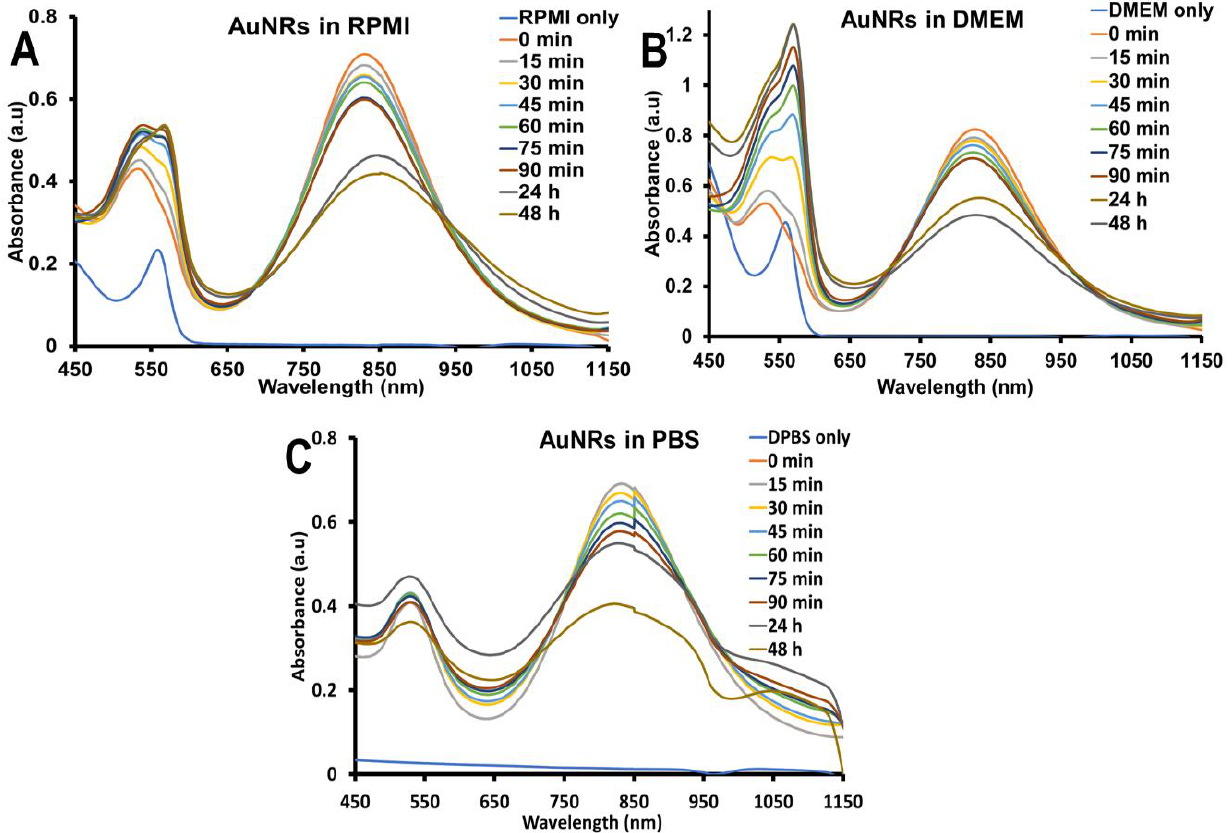
Figure 3. The absorption spectrum of AuNRs in ( A ) RPMI at ratio volume, ( B ) DMEM, and ( C ) DPBS at volume ratio (1:1).